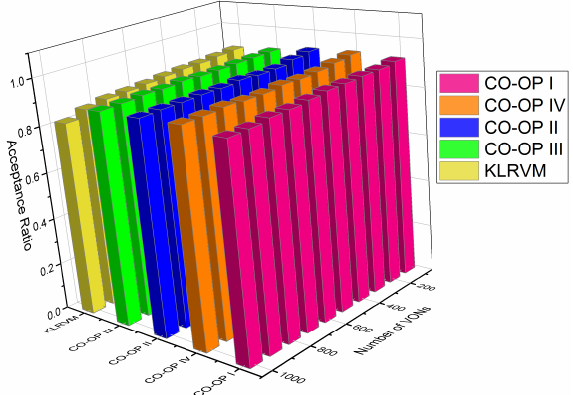
Figure 9. Acceptance ratio for the CHNNET